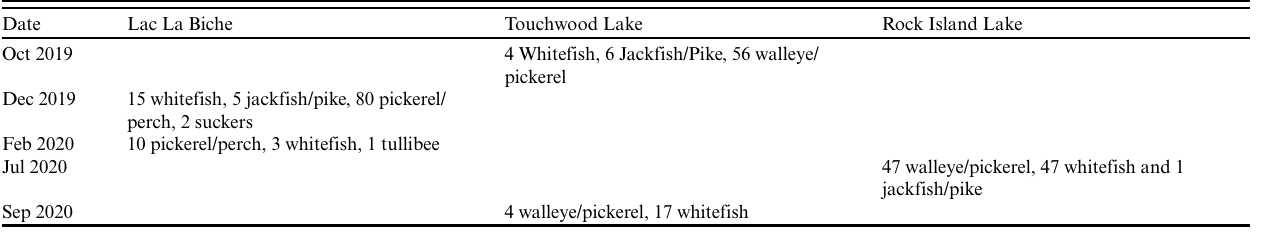
Table 3. Fish counts by lake during cultural camps,